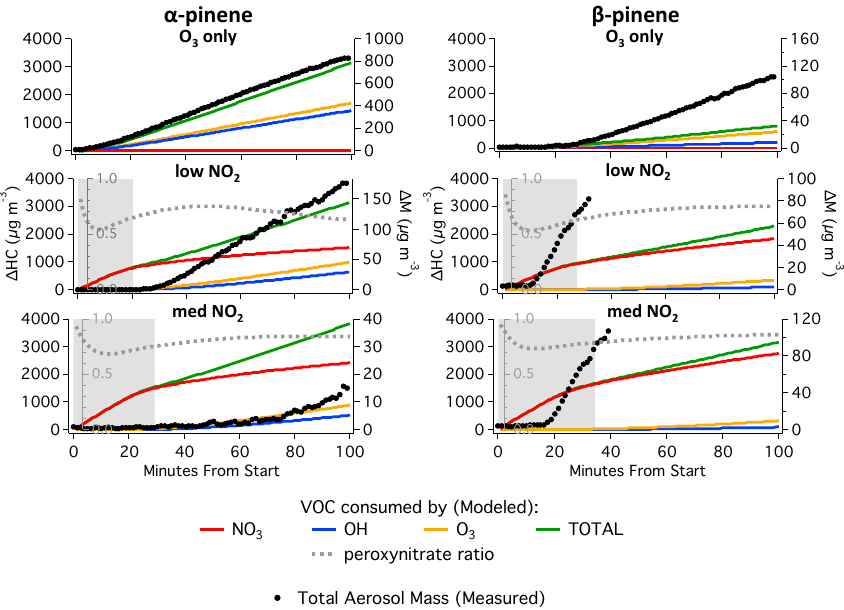
Figure 5. Time series of wall-loss-corrected aerosol mass (right axis) and VOC consumed by each oxidant (left axis) for α -pinene and β - pinene at 0 (“O 3 -only”), low, and medium NO 2 concentrations, highlighting how much aerosol is produced at times dominated by NO 3 oxida- tion (shaded regions). (cid:49) HC values shown are the lower limits calculated using the lowest RO 2 + RO 2 rate constant (10 − 15 cm 3 molec − 1 s − 1 ), which gives the low limit on how much NO 3 reacts with VOC directly. Dashed grey traces (inner left grey axis) represent the ratio of RO 2 + NO 2 products that are present in the chamber (instantaneous concentration) relative to the sum of the instantaneous concentrations of RO 2 + RO 2 , RO 2 + NO 3 , and RO 2 + NO 2 products. This ratio is a representation of the time dependence of peroxy nitrate formation in the